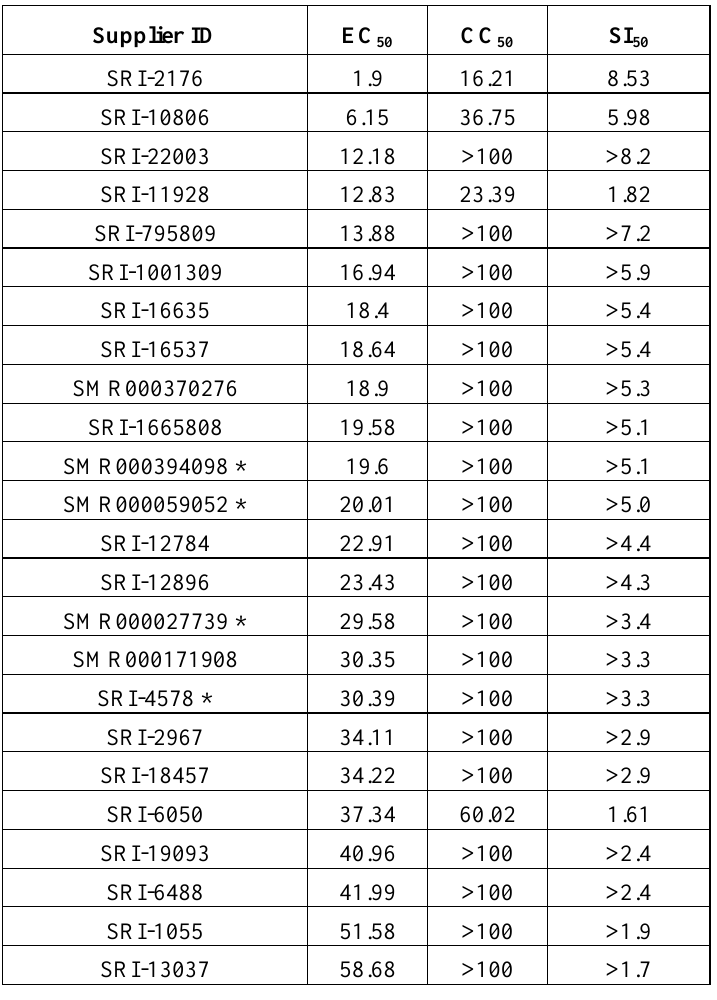
Table 1. Twenty-four compounds selected from the primary and dose response